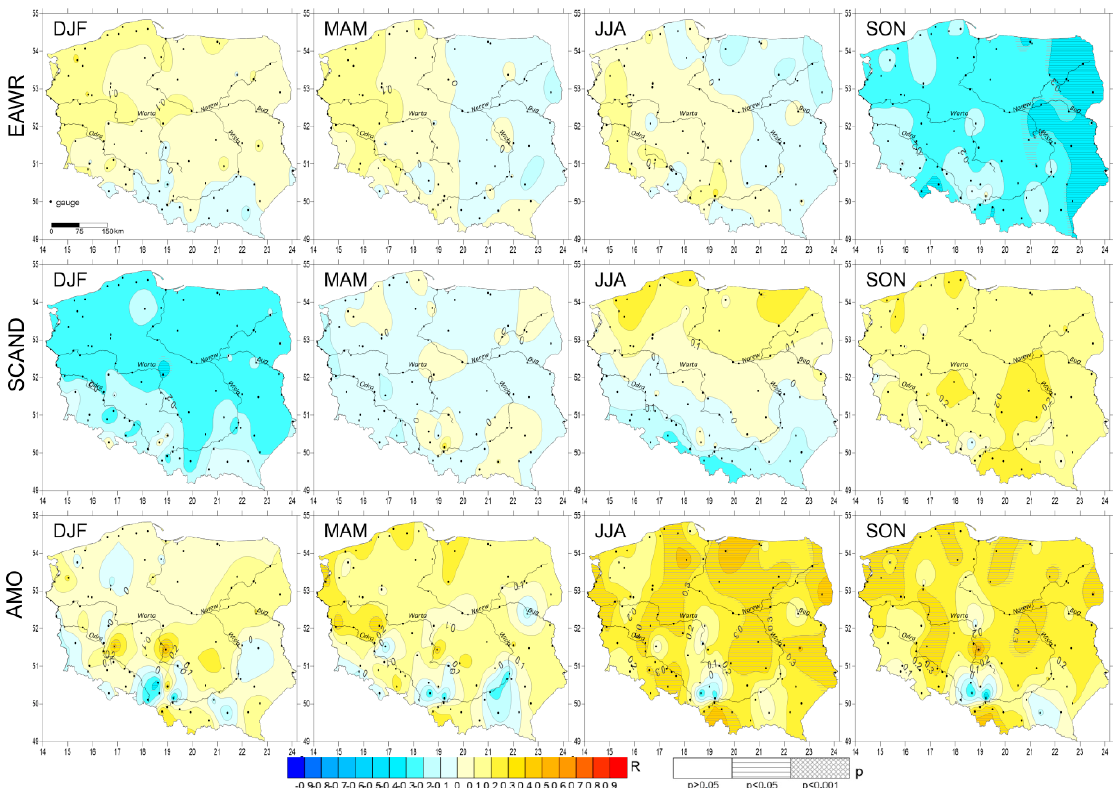
Figure 9. Spatial distribution of coefficients of correlation (R) between seasonal water temperature values and circulation types EA/WR, SCAND, and AMO, and their statistical significance (p).